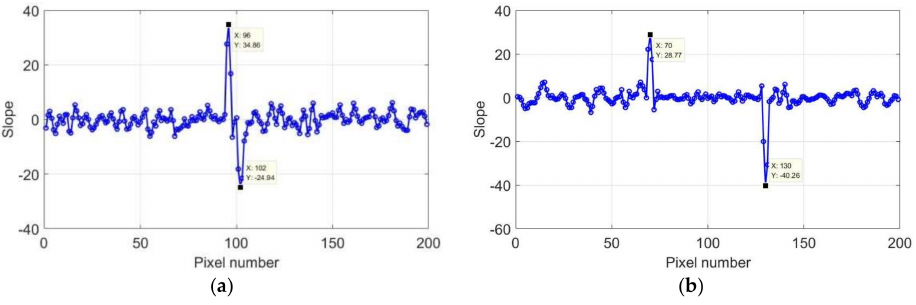
Figure 14. Slope of first derivation of 1.5 mm: ( a ) horizontal and ( b ) vertical